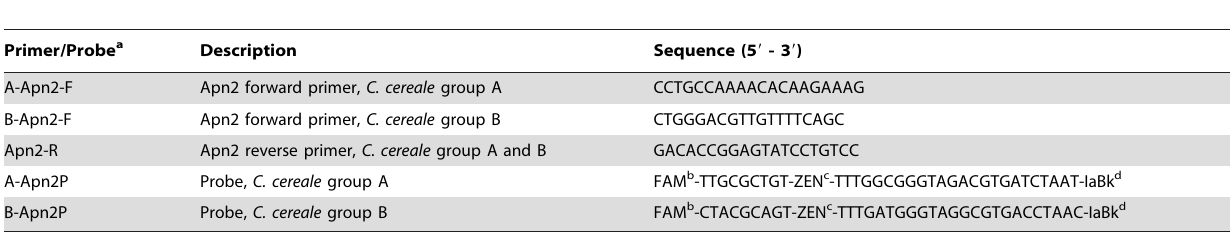
Table 1. Real-time polymerase chain reaction primers and dual labeled hydrolysis probes developed in this study for detection of Colletotrichum cereale subspecific